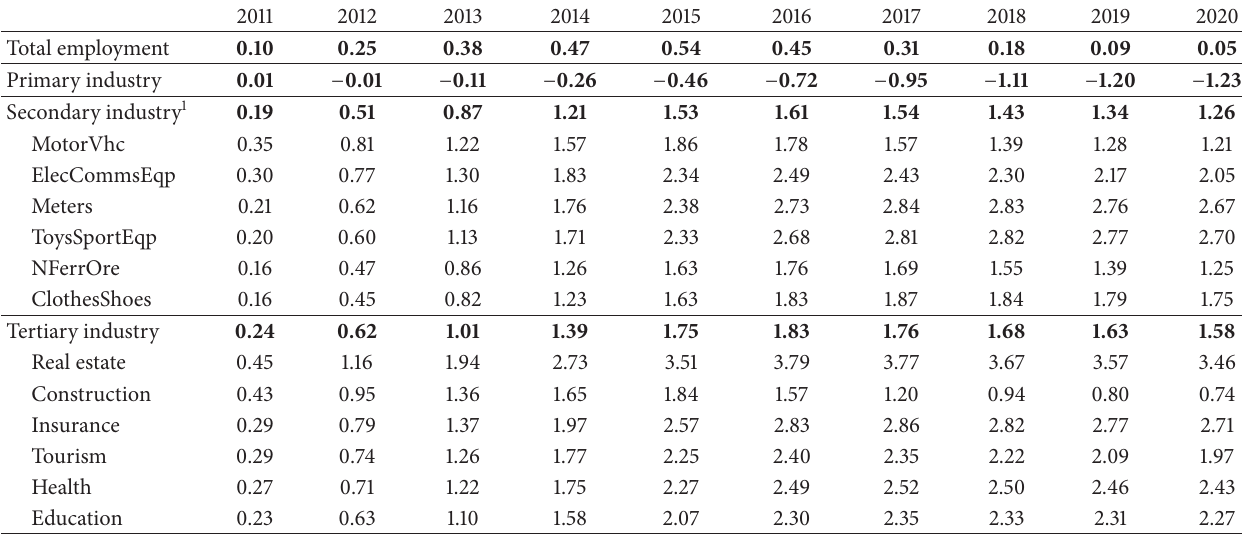
Table 2: The total employment (% change deviation from baseline).